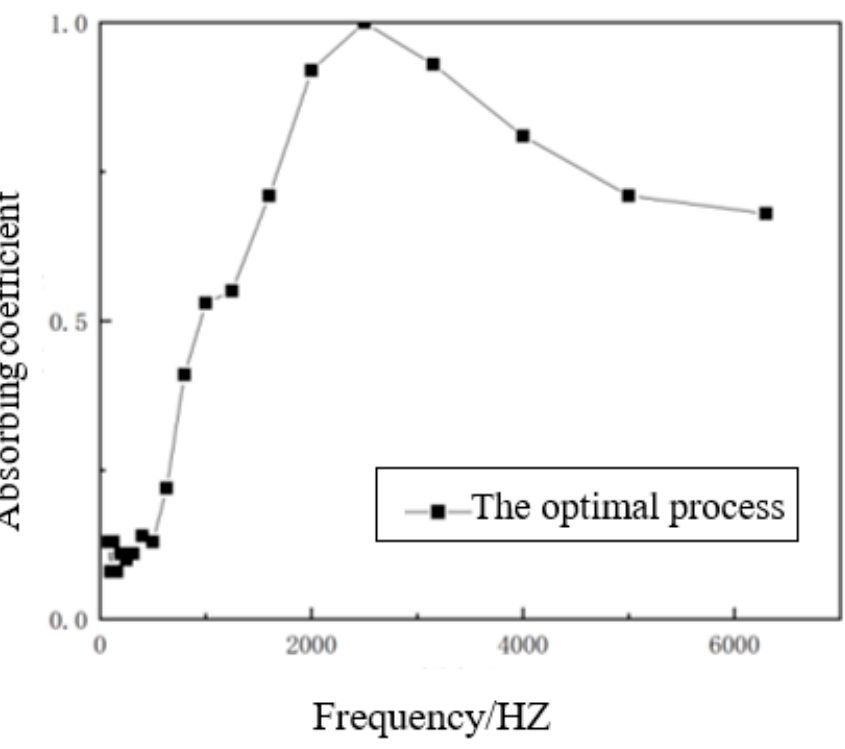
Figure 13. Sound absorption coefficient curve of the optimal processed composite material.